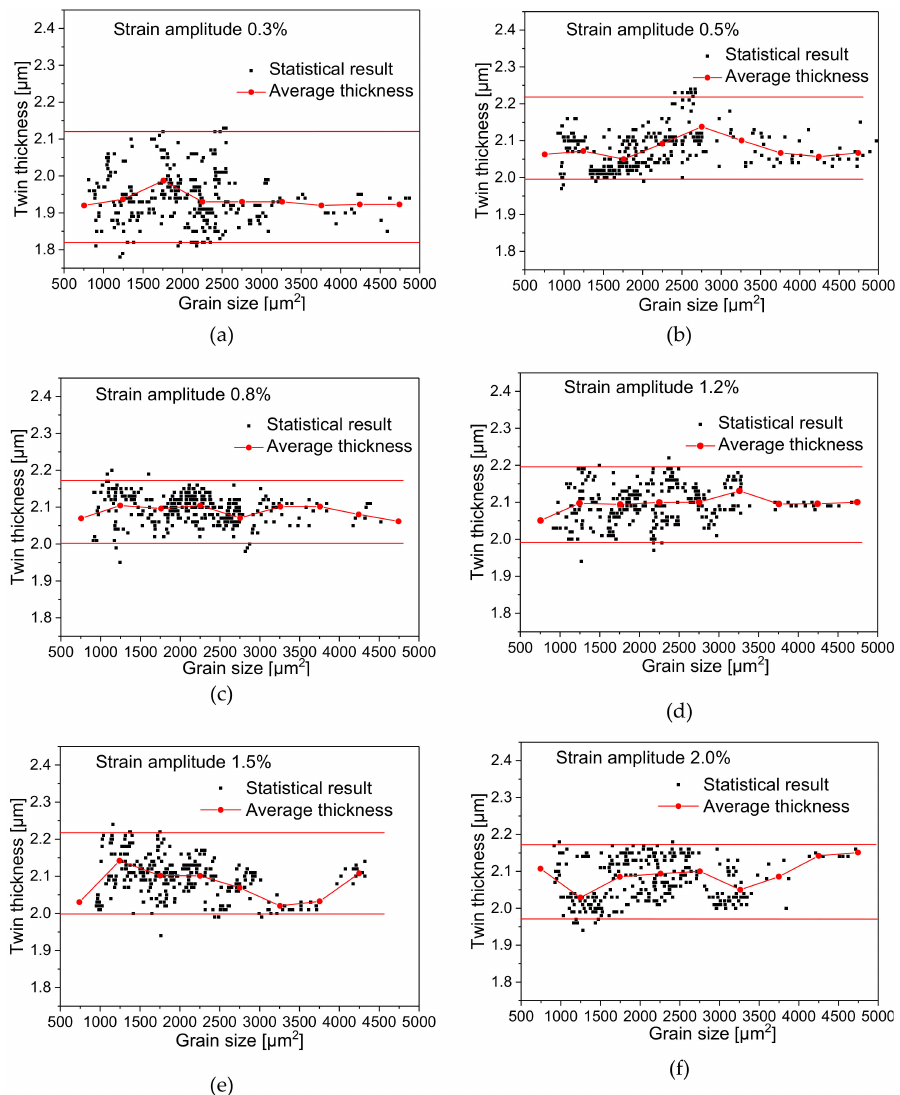
Figure 9. Distribution diagram of the relationship between grain area size and average twin thickness at di ff erent strain amplitudes: ( a ) 0.3%; ( b ) 0.5%; ( c ) 0.8%; ( d ) 1.2%; ( e ) 1.5%; ( f )